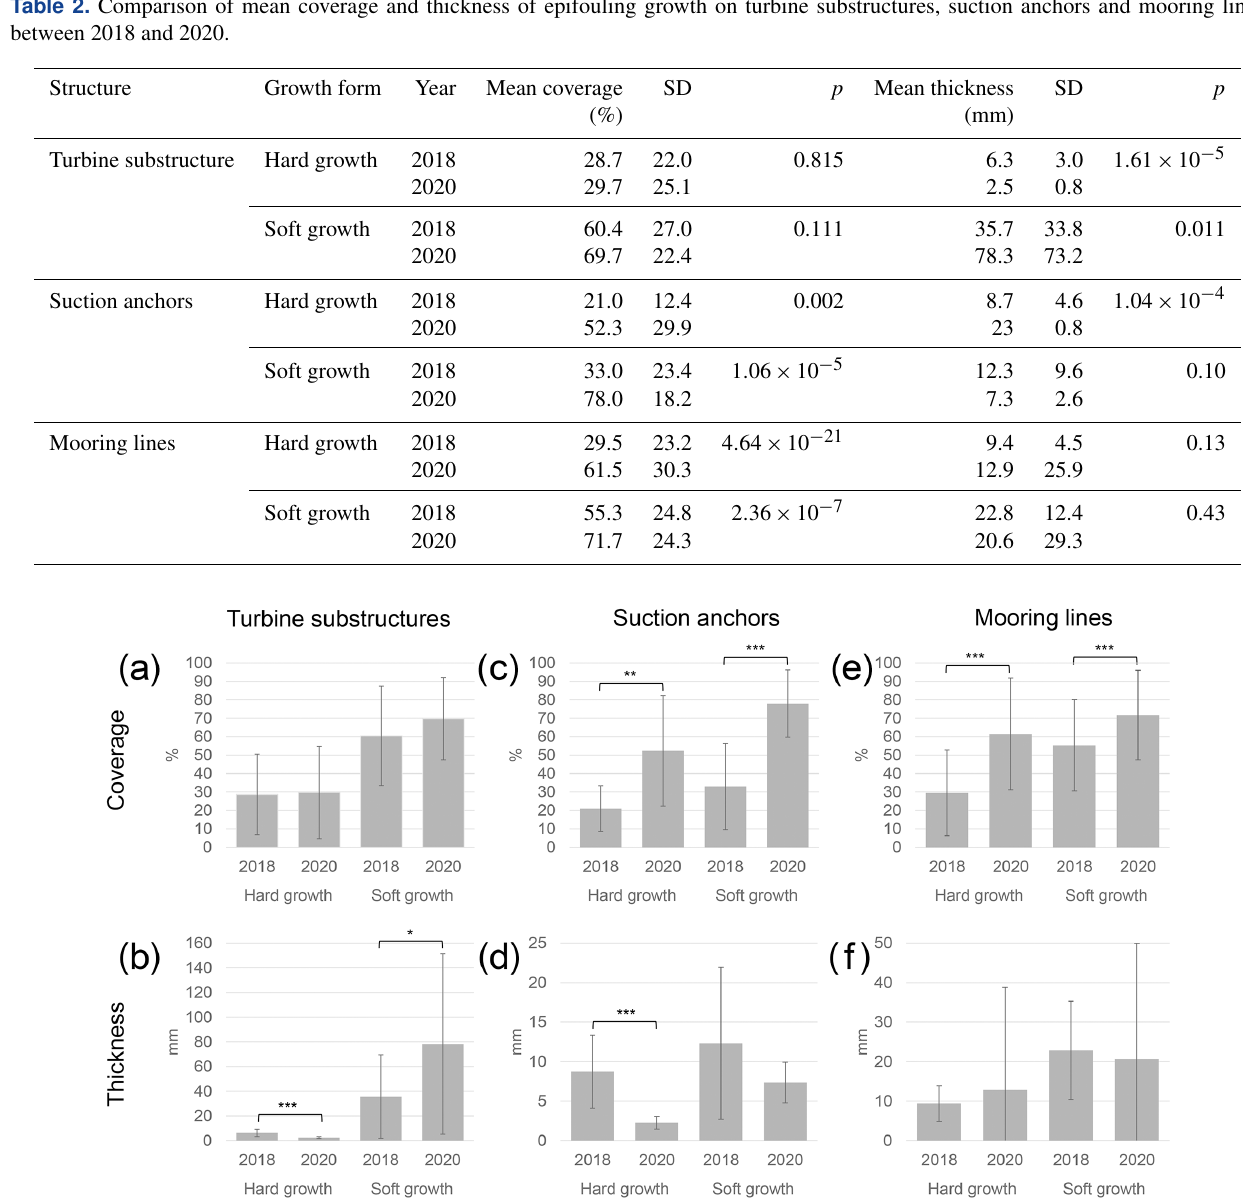
Figure 8. Coverage and thickness of epifouling growth, shown as mean. Asterisks represent statistically significant differences between years, based on a two-tailed paired t test ( ∗ p< 0 . 05; ∗∗ p< 0 . 01; ∗∗∗ p< 0 . 001). Error bars show ± 1 SD. Note the different scales between (b) , (d) and (e)